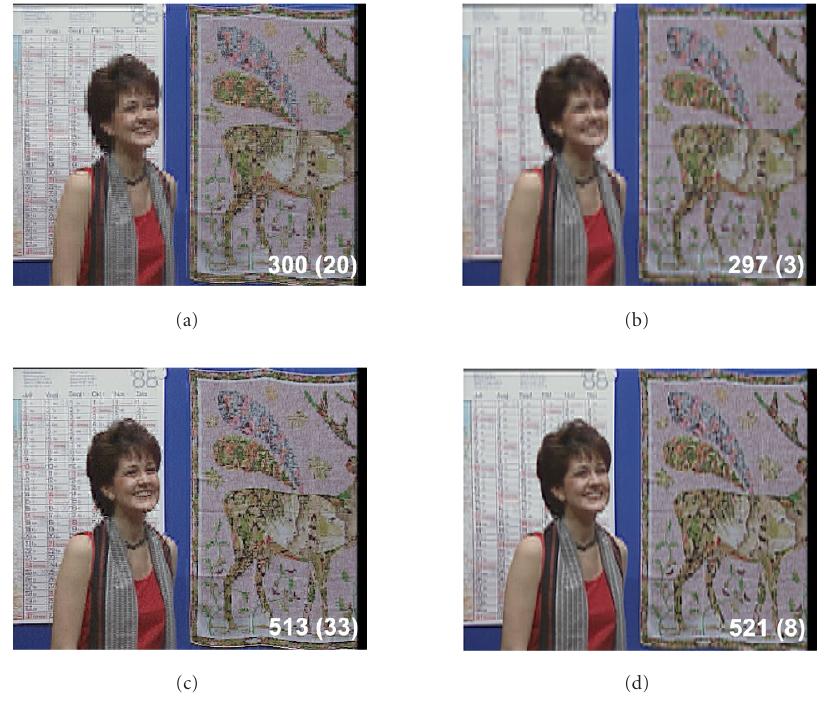
Figure 7: A video frame from the “Renata” sequence coded employing the scalability-optimized order (a) and (c), and the zigzag order (b) and (d). Index m ( n ) means m operations are performed for n coe ffi cients. The scalability-optimized computation order results in an improved quality (compare sharpness and